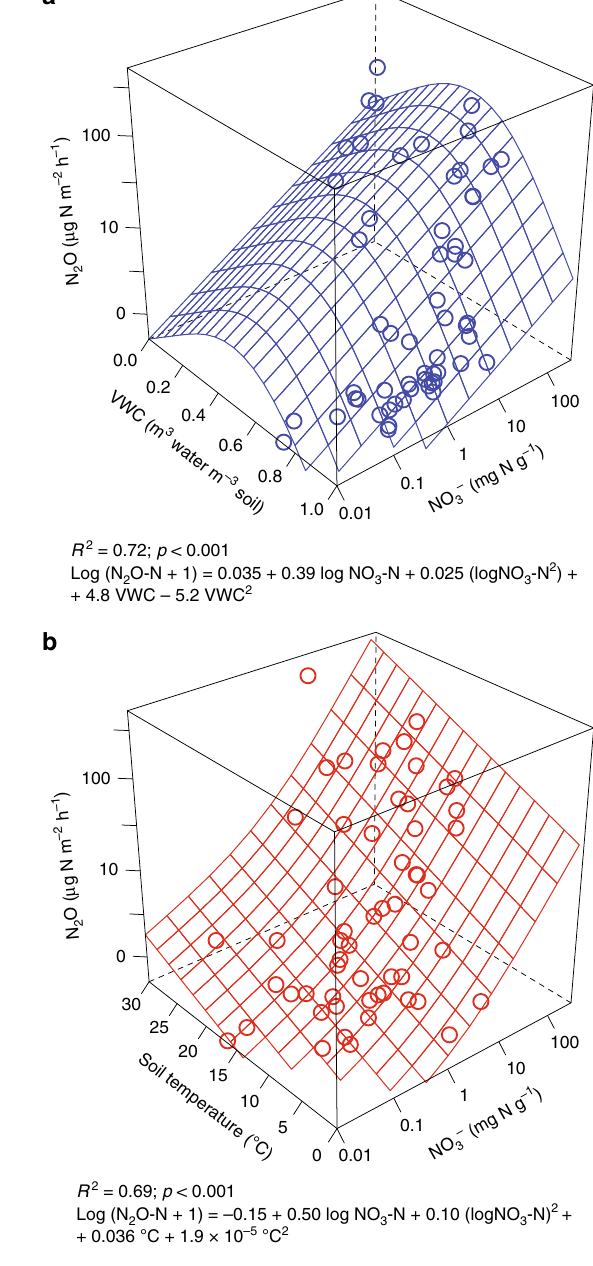
Fig. 4 Site-mean N 2 O fl ux multiple-regression models. a Soil nitrate and volumetric water content (VWC); b soil nitrate and temperature at 40